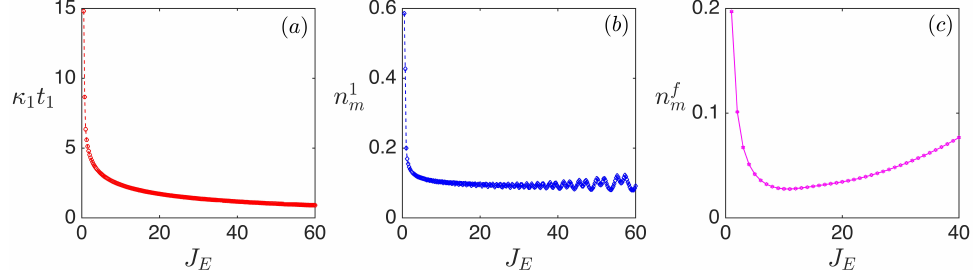
Figure 3. Relations between the three figures of merit with the effective coupling intensity J E in the scenario of two pulsed drives. ( a ) The evolution time for reaching the first minimum phonon number vs. the effective coupling intensity. ( b ) The first minimum phonon number vs. the effective drive intensity. There exists oscillation if J E > 10. ( c ) The final minimum phonon number vs. the effective coupling intensity. The quantity increases when J E > 10. The fixed system parameters are the same as those in Figure 2.